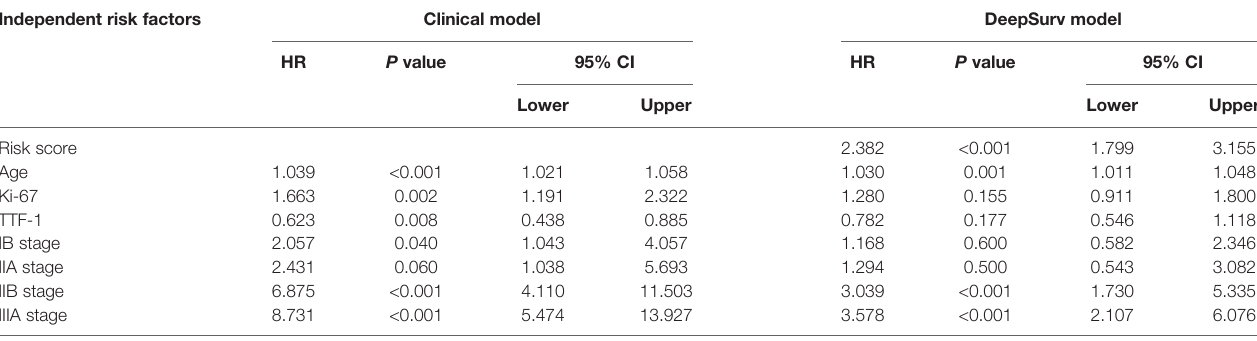
TABLE 2 | Multivariate Cox proportional hazards (CPH) model regression analysis of independent risk factors. Independent risk factors